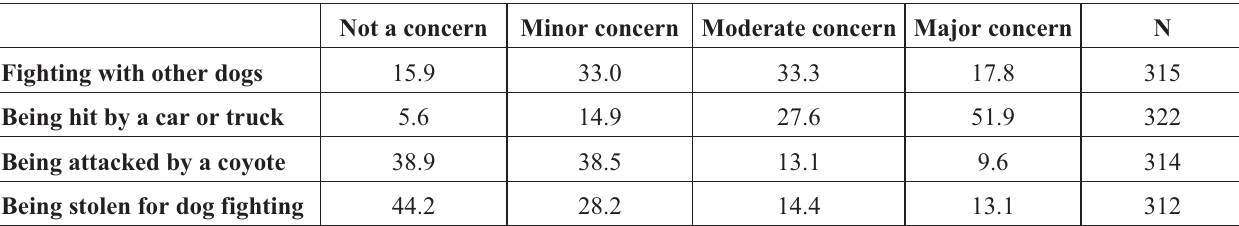
Table 6. Pet owners’ responses to: “Please indicate how concerned you are that the following could happen to dogs that are outside unsupervised or are off-leash in the D.C. metro area.” Given in percentages.